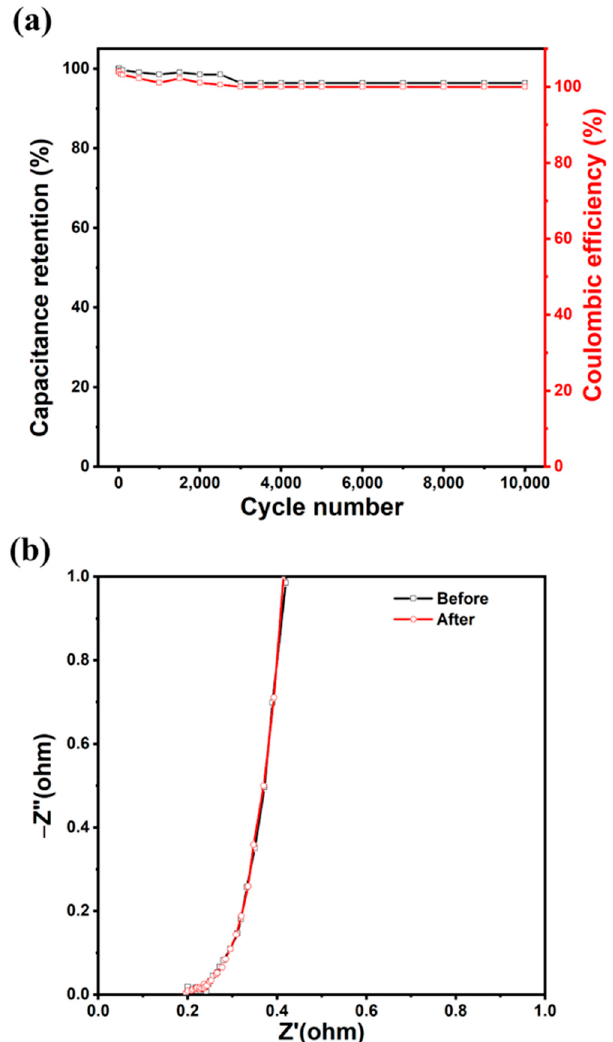
Figure 8. ( a ) Cycling performance, and ( b ) Nyquist plots before/after the cycling test of the CNTs/NF electrode.